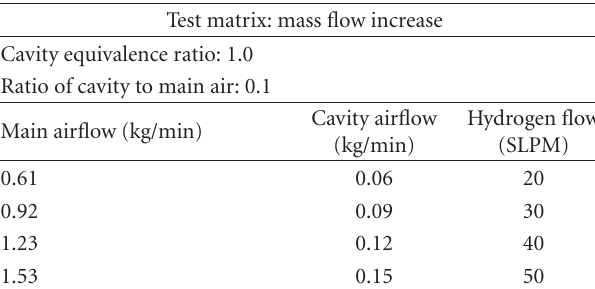
Table 2: Test matrix for velocity study. Test matrix: mass flow increase Cavity equivalence ratio: